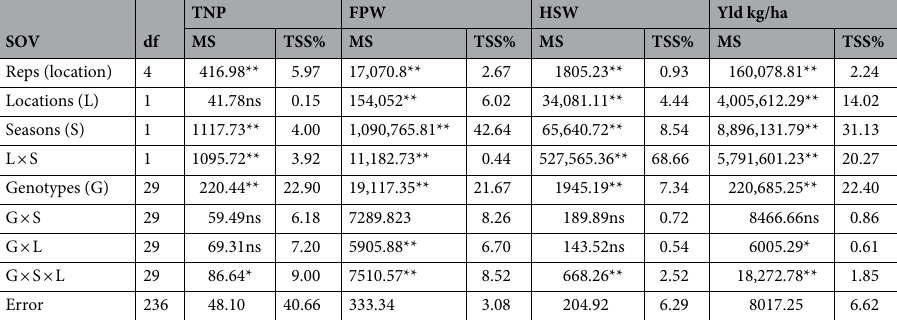
Table 4. Estimation of significant level for yield and yield contributed traits of 30 V . subterranea accessions revealed by ANOVA. SOV source of variation, df degree of freedom, TNP total number of pod, FPW fresh pod weight, HSW hundred seed weight (g), Yld Yield (kg/ha). *Significant at p ≤ 0.05; **highly significant at p ≤ 0.01; ns = non-significant p >